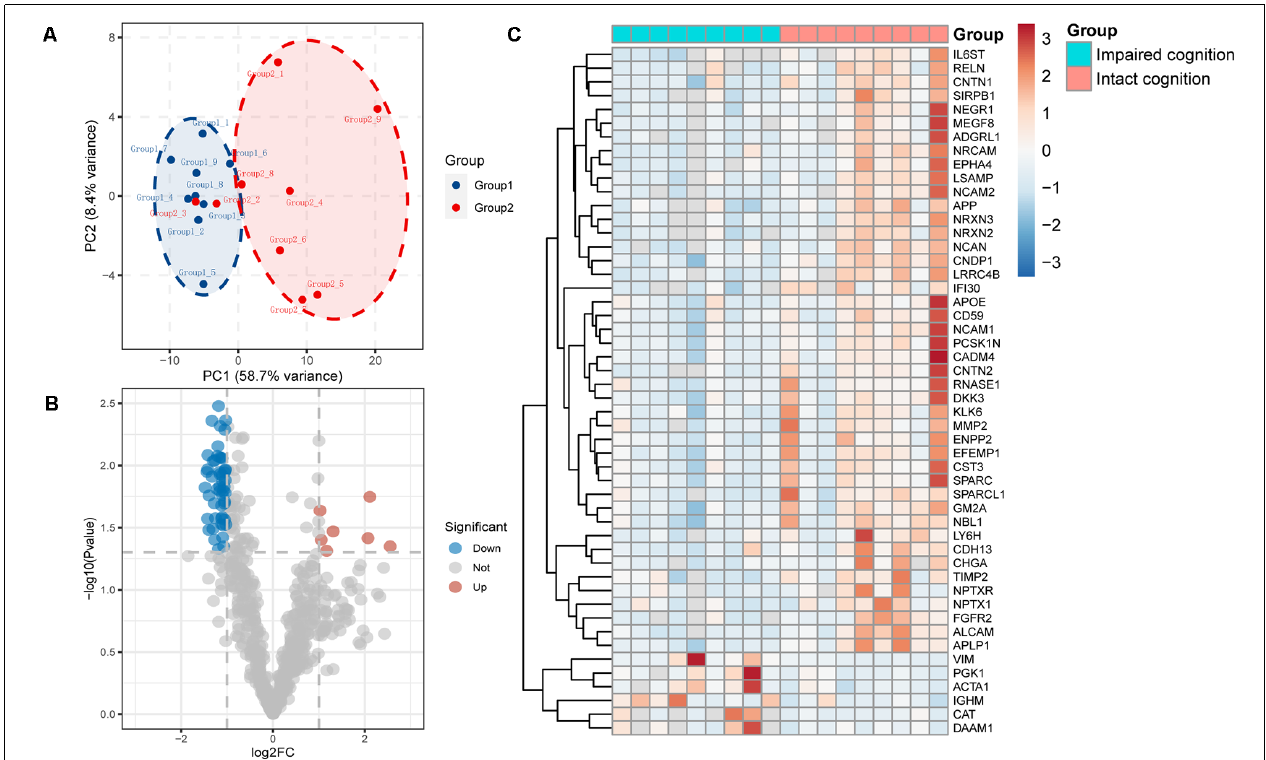
FIGURE 1 | Proteomic data analysis within the impaired cognition and intact cognition groups. (A) PCA of the two groups. The PCA plot shows principal components 1 and 2 (PC1 and PC2), which explain 58.7% and 8.4% of the total variance, respectively. (B) Volcano plot shows differentially expressed proteins between the two groups. The horizontal axis indicates log 2 (fold change). The vertical axis indicates − 10 log p values. Each dots represents a protein, dots in red and blue have a fold change > 1.5 and p value < 0.05 analyzed by Student’s t -test. The gray dots represent proteins with no statistically significant difference in expression. (C) Heatmap of mass spectrometry data from CSF samples of individuals in the impaired cognition group ( n = 9) and the intact cognition group ( n = 9). Red indicates upregulation, and blue indicates downregulation.